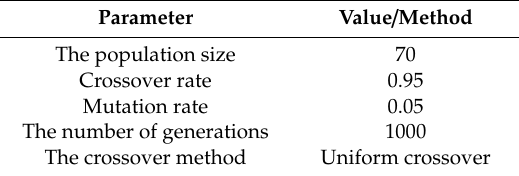
Table 2. Non-dominated Sorting Genetic Algorithm II (NSGA-II) parameters.